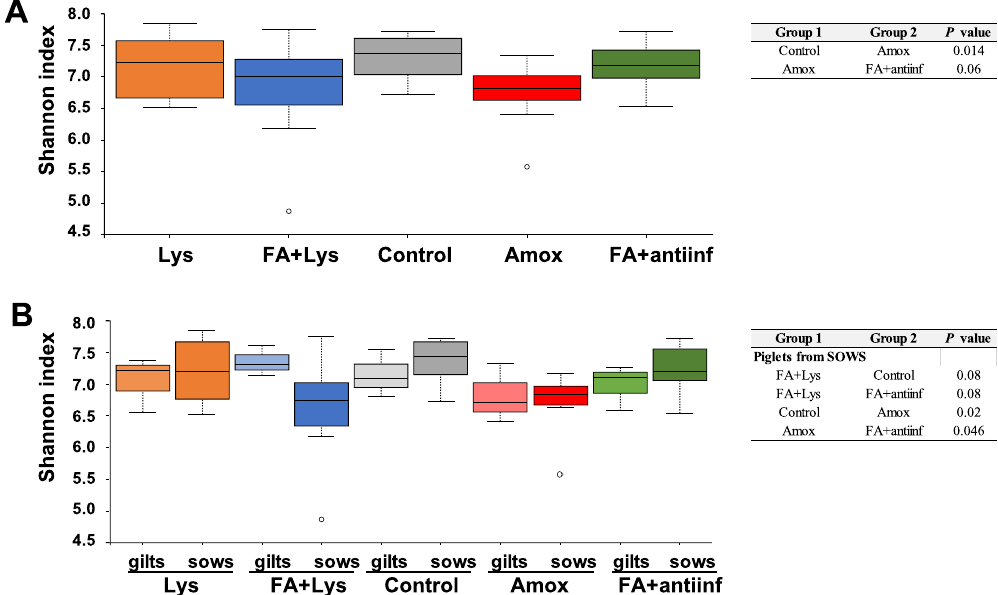
Figure 3. Alpha diversity of faecal microbiota is different depending on the treatment group. Diversity was estimated using Shannon’s index at D21 on faecal samples for the treatment groups ( A ) or considering the parity of the dams ( B ). The dotted lines represent standard deviation and outliers are indicated with white circles. The alpha significance is shown in the right panel indicating the P values, when significant. The treatment groups were: Lys lysozyme, FA + lys medium chain fatty acids and lysozyme, C control, with no additives, Amox amoxicillin, FA + antiinf medium chain fatty acids and a natural antiinflammatory; each group was splitted